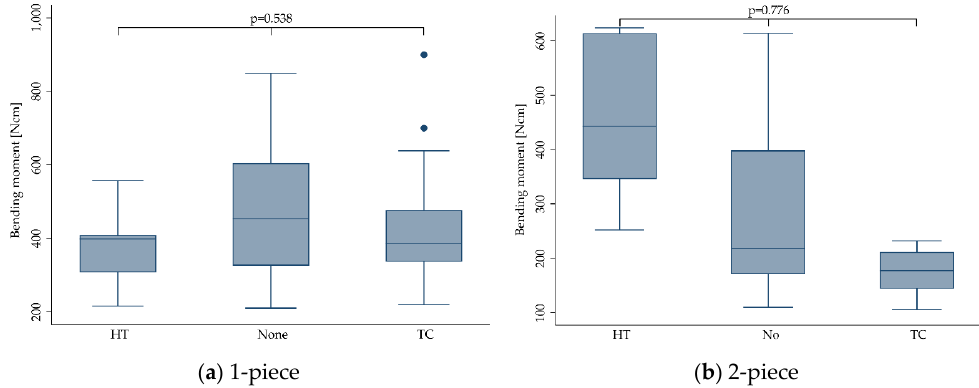
Figure 8. Boxplots showing the bending moment at the time point of fracture, depending on the thermal aging conditions (none, HT = high temperature, TC = thermal cycling) for 1- ( a ) and 2-piece ( b ) zirconia implants. Whiskers are used to represent all samples lying within 1.5 times the interquartile range. Dots represent outliers. Detailed data can be found in Tables 3 and 4.